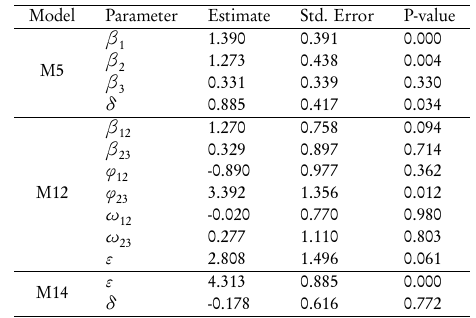
The parameter estimates of M5, M10, and M14